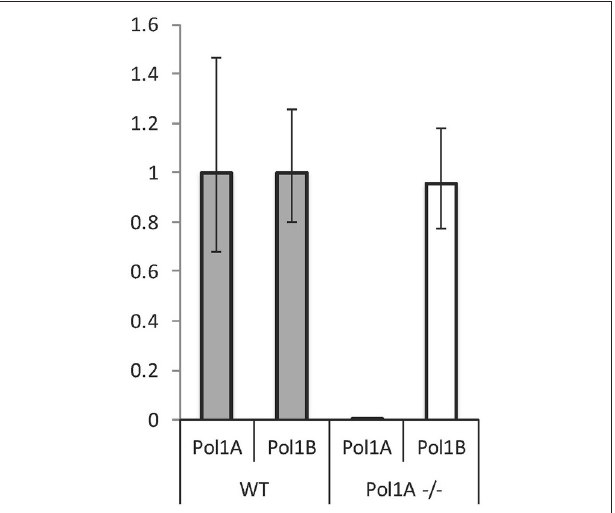
FIGURE 3 | RT-PCR of Pol1A and Pol1B expression in PolIA mutant plants. Although previous work has suggested that mutation in Pol1B causes an increase in Pol1A expression, mutation of Pol1A does not affect expression of Pol1B. This experiment shows relative levels of each polymerase transcript normalized against Actin mRNA. Although mutation in Pol1A knocks down its expression, no significant change in Pol1B expression can be